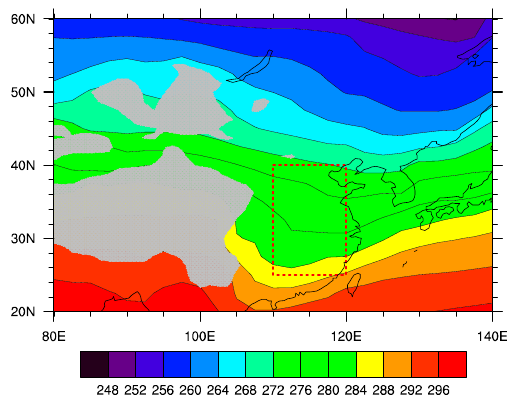
Figure 8. Forty-year climatological mean of winter (November to March) 1000 hPa air temperature (K). Dashed red rectangle represents southern China; gray shading represents topographic height exceeding 1500 m.